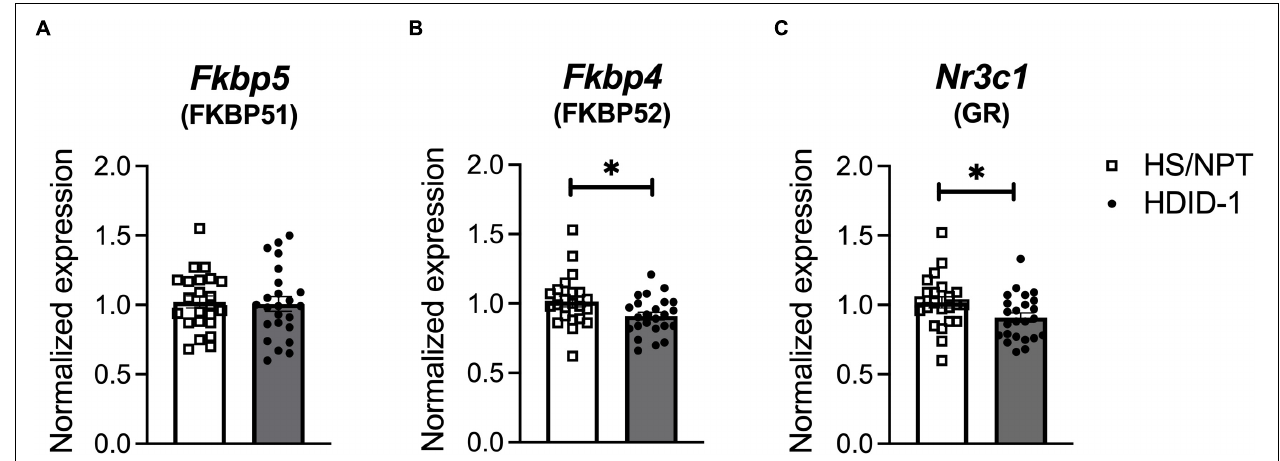
FIGURE 2 | HDID-1 mice have reduced basal Nr3c1 and Fkbp4 NAc gene expression relative to their HS/NPT founders. Baseline gene expression of GR ( Nr3c1 ), FKBP51 ( Fkbp5 ), and FKBP52 ( Fkbp4 ) was analyzed in the NAc of HDID-1 and HS/NPT mice ( n = 11–12/sex/line). (A) No group differences were observed in Fkbp5 expression. (B,C) HDID-1 mice have reduced expression of Fkbp4 and Nr3c1 relative to their founders, HS/NPT. Means ± SE shown. ∗ p < 0.05.